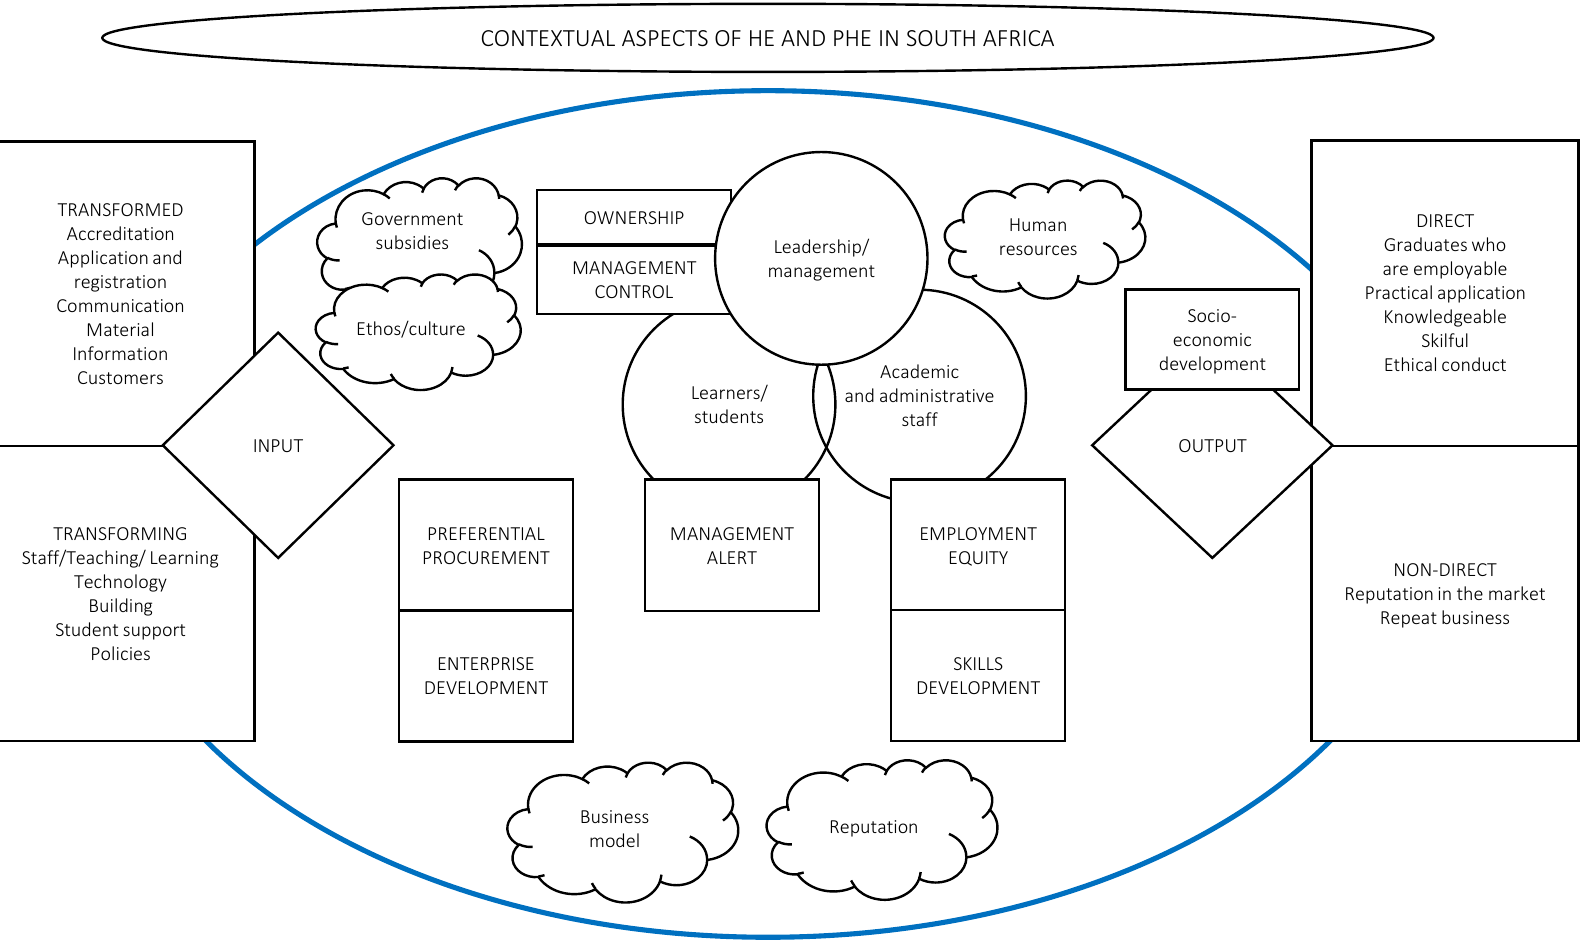
Figure 1. The TQS framework with superimposed BEE scorecard